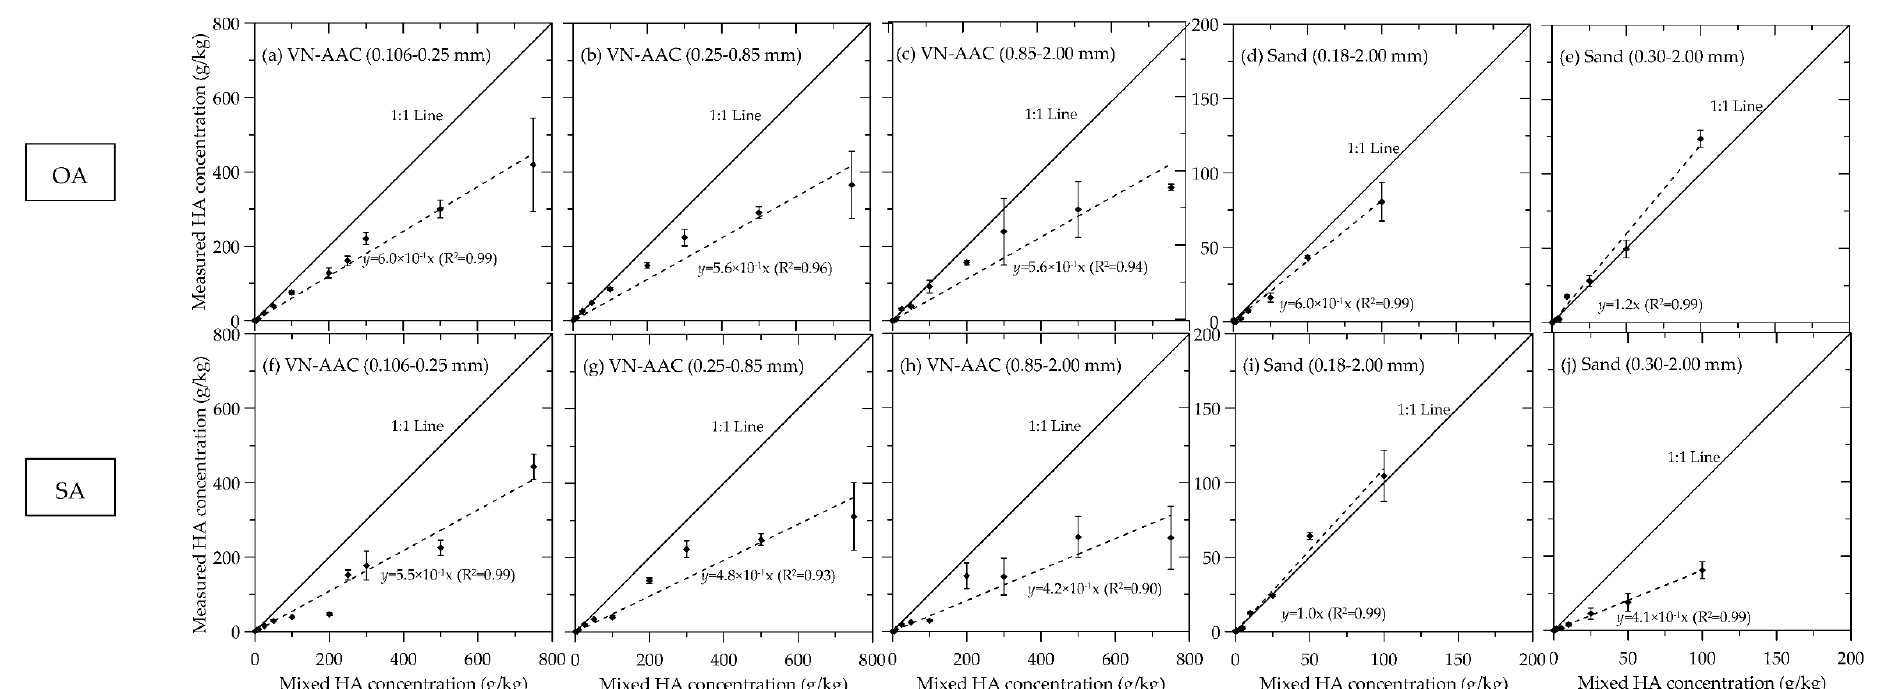
Figure A1. Relationships between measured and mixed HA concentrations for OA- and SA-coated VN AAC grains and sands. OA-coated VN-AAC grains: ( a ) Grain size = 0.106 – 0.25 mm, ( b ) Grain size = 0.25 – 0.85 mm, and ( c ) Grain size = 0.85 – 2.00 mm. OA-coated sands: ( d ) Grain size = 0.18 – 2.00 mm and ( e ) Grain size = 0.30 – 2.00 mm. SA-coated VN-AAC grains: ( f ) Grain size = 0.106 – 0.25 mm, ( g ) Grain size = 0.25 – 0.85 mm, and ( h ) Grain size = 0.85 – 2.00 mm. SA-coated sands: ( i ) Grain size = 0.18 – 2.00 mm and ( j ) Grain size = 0.30 – 2.00 mm.